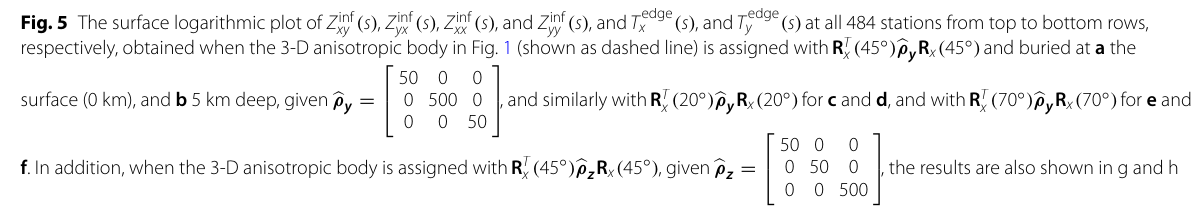
ρ y R x ( 45 ◦ ) and buried at a the 50 0 0 (cid:31) 0 500 0 ρ y R x ( 20 ◦ ) for c and d , and with R T x ( 70 ◦ ) ρ y R x ( 70 ◦ ) for e and ρ y =  , and similarly with R T x ( 20 ◦ )  0 0 50   (cid:31) (cid:31) � ρ z R x ( 45 ◦ ) , given , the results are also shown in g and  0 0 500  (cid:31)